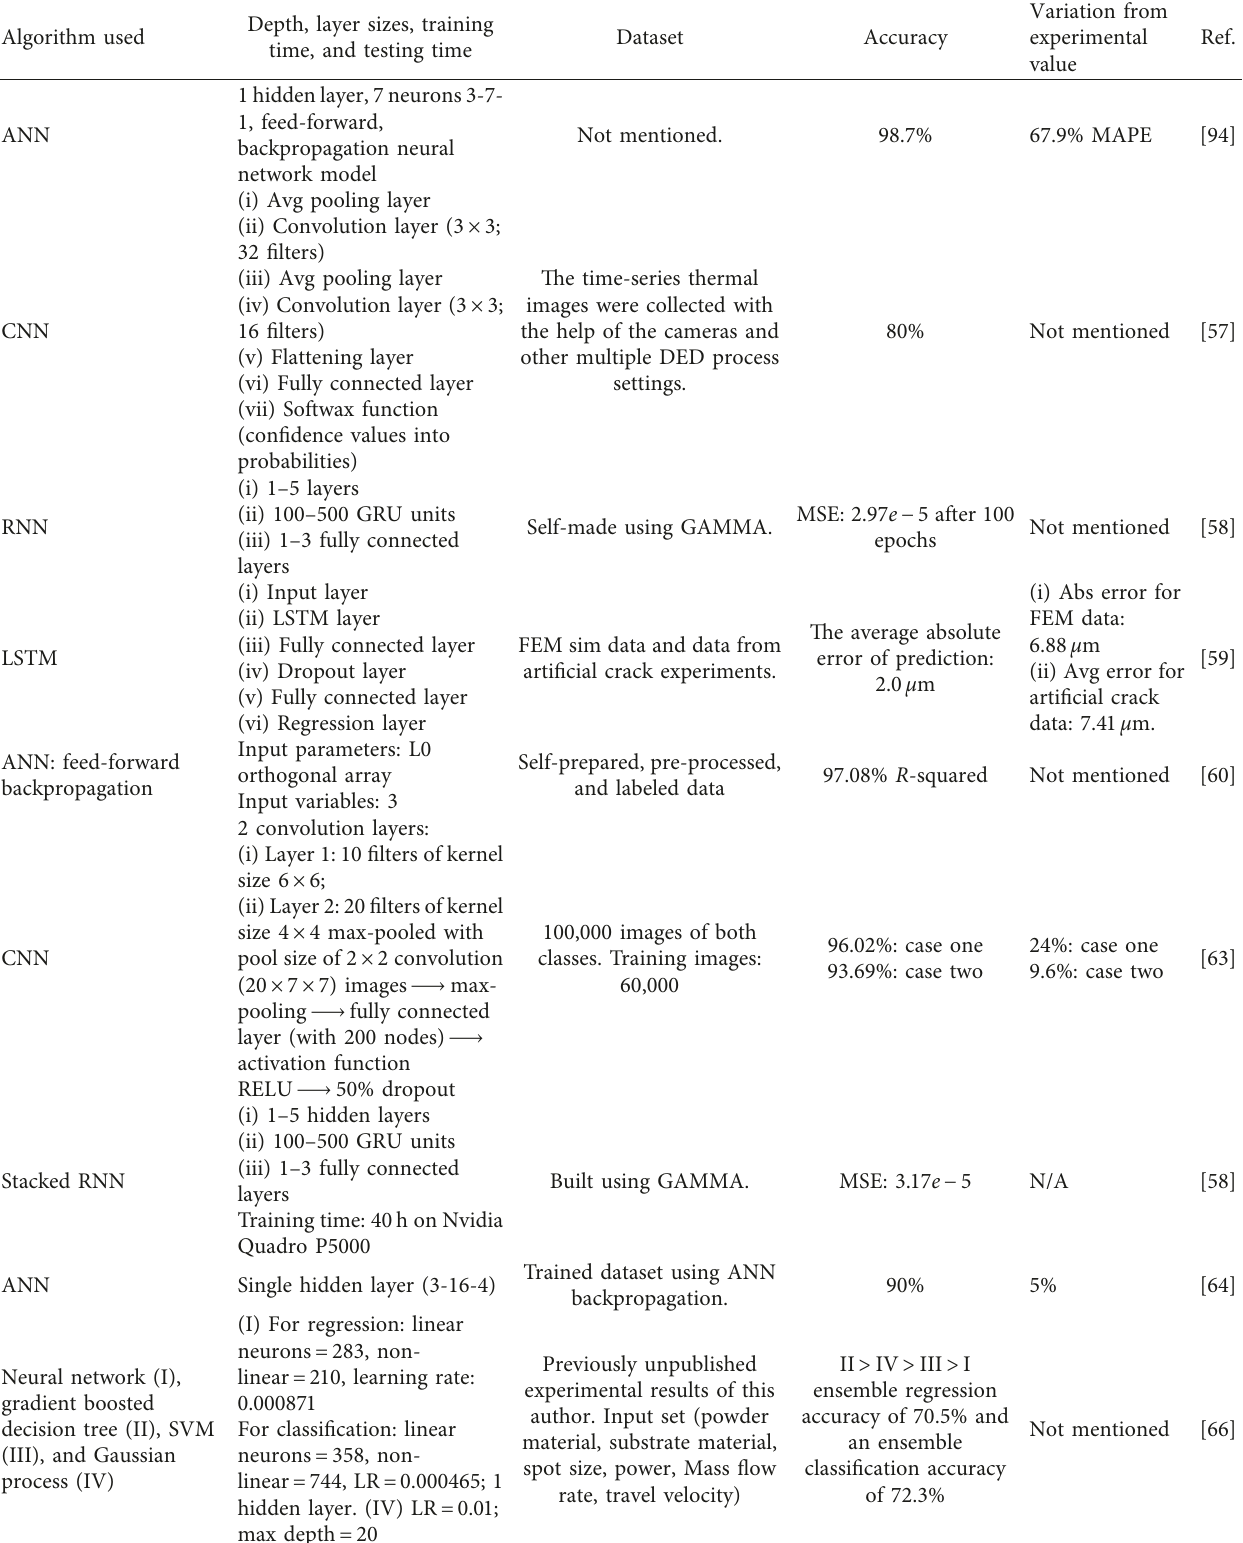
Table 10: Comparison between various network models used. Algorithm